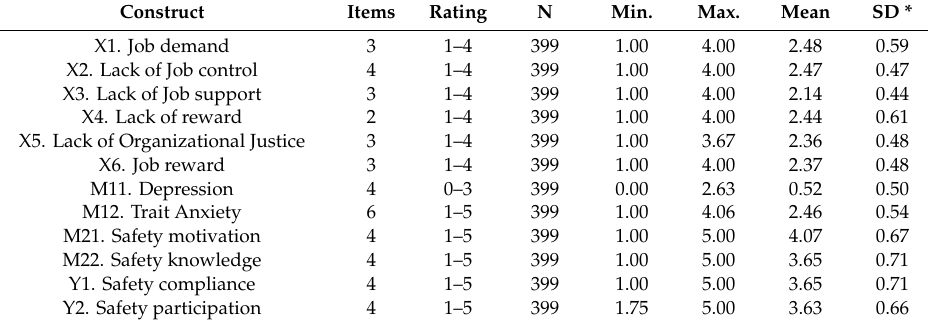
Table 5. Statistics of the research